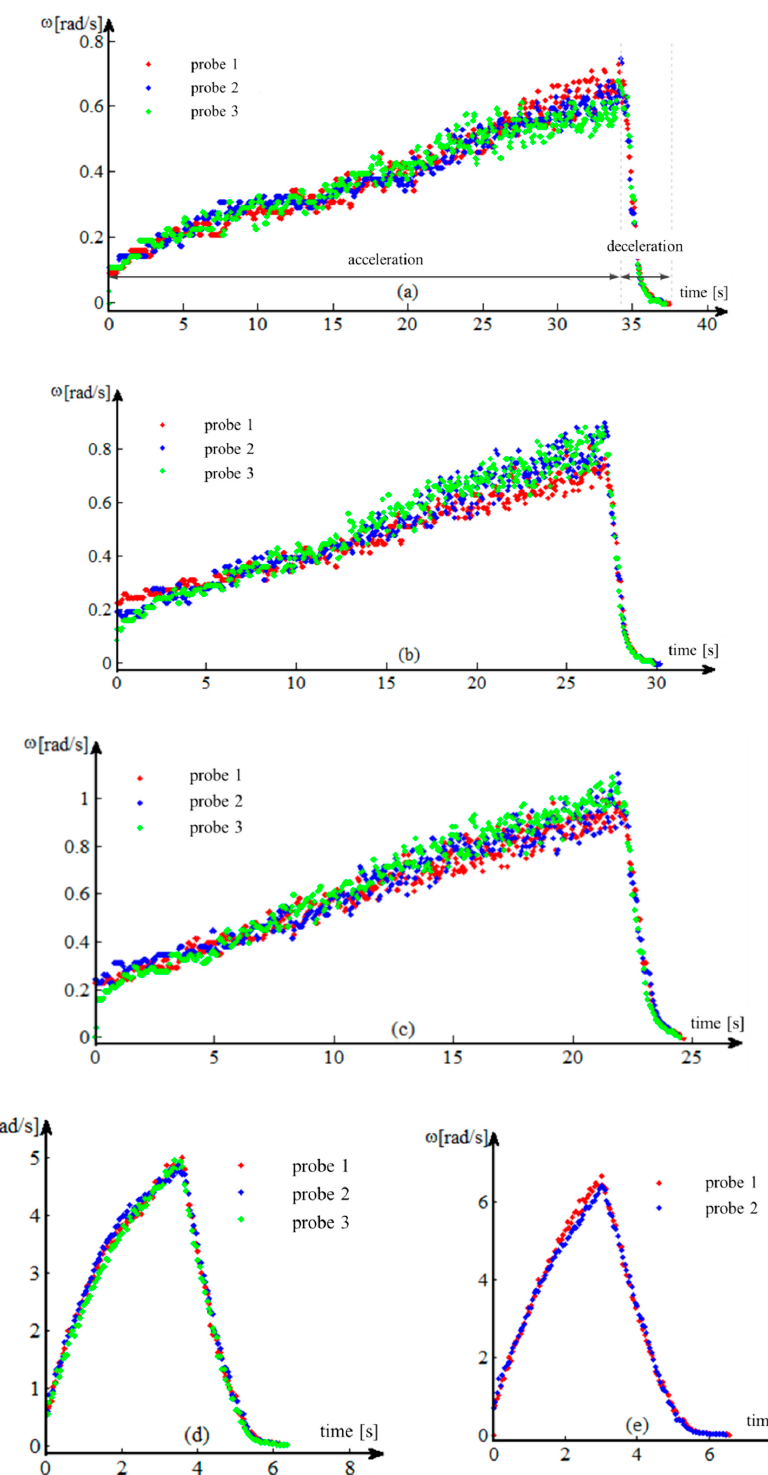
Figure 20. Variation of the angular speed of the drive wheel. ( a ) Operation in I gear; ( b ) operation in II gear; ( c ) operation in III gear; ( d ) operation in IV gear; ( e ) operation in neutral.